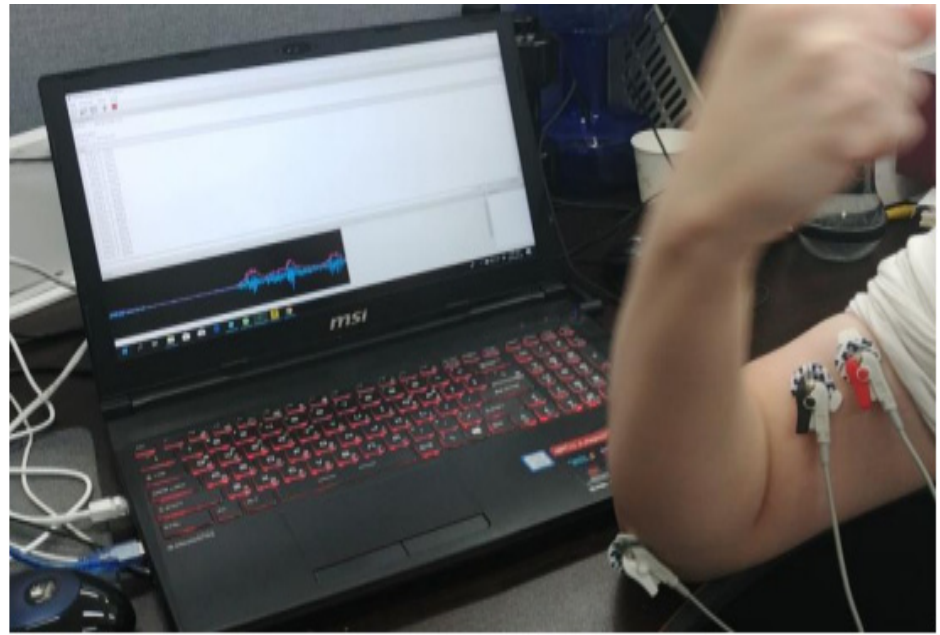
Figure 18. EMG sensor output while a virtual lifting process.